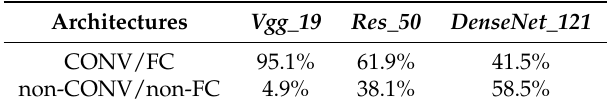
Table 9. Computational time trade off between convolutional and fully-connected layer versus other layer topologies